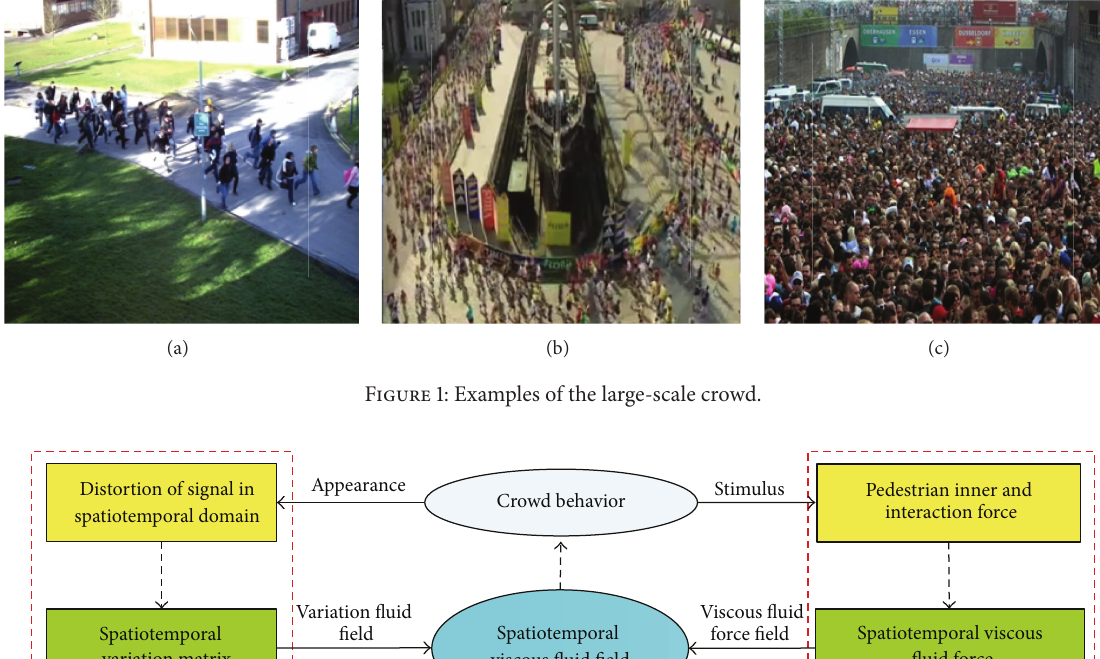
Figure 2: Theoretical framework of crowd behavior